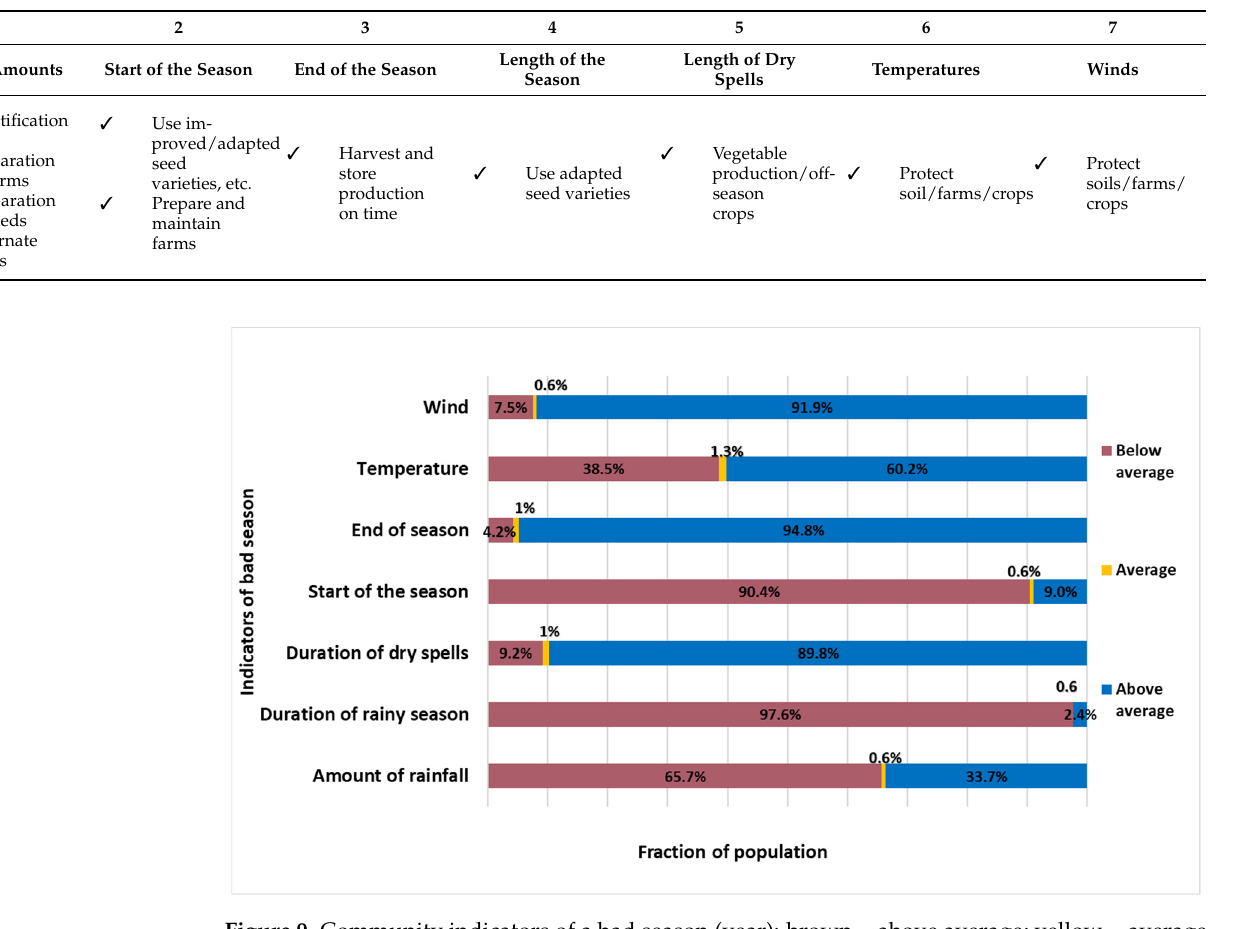
Table 5. Strategies to implement against a bad agropastoral season.